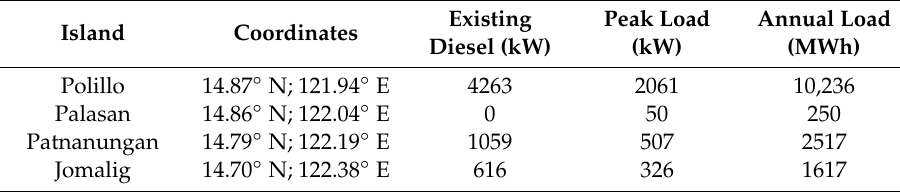
Table A4. Relevant parameters about each island.